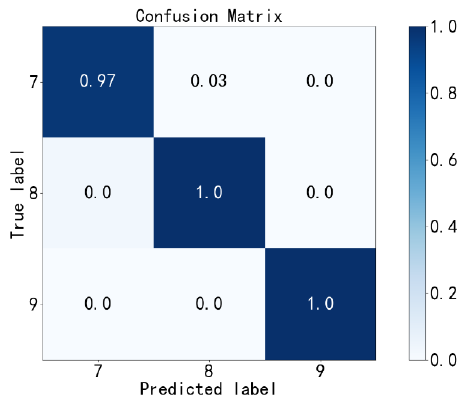
Figure 13. Fourth fault diagnosis with the PE method.